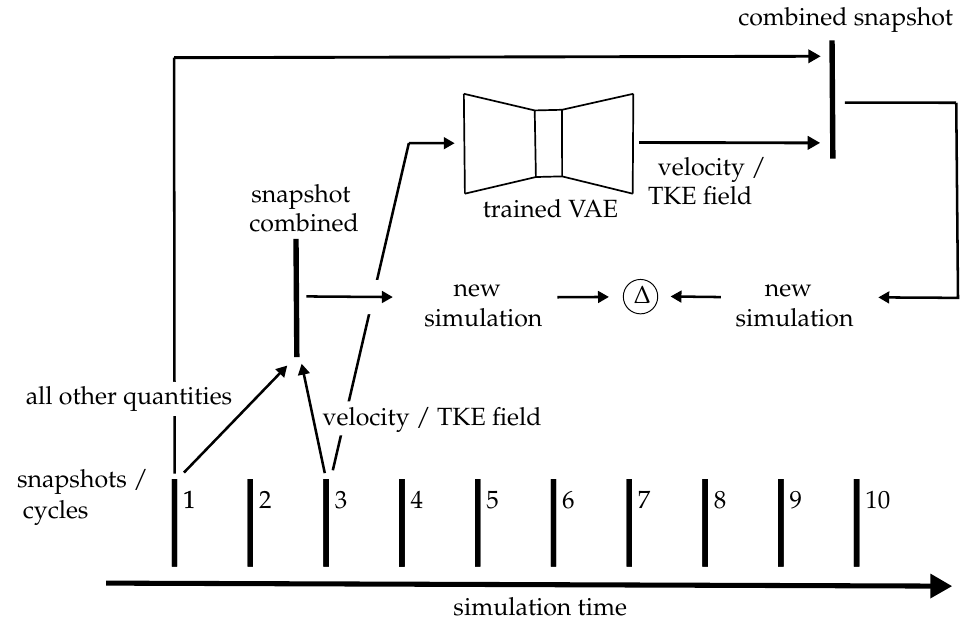
Figure 6. Procedure to validate the ability of the VAE to generate meaningful artificial velocity and TKE fields.